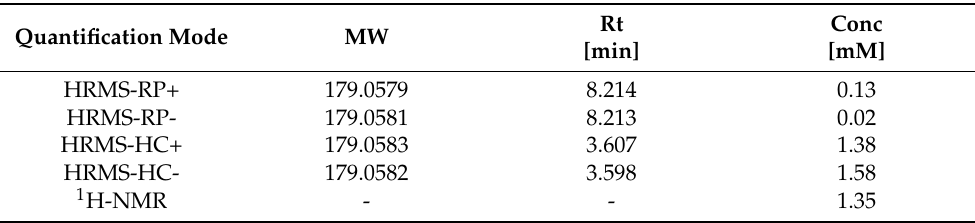
Table 3. Concentrations obtained for hippuric acid from the four MS hits and NMR for a sample belonging to a BC